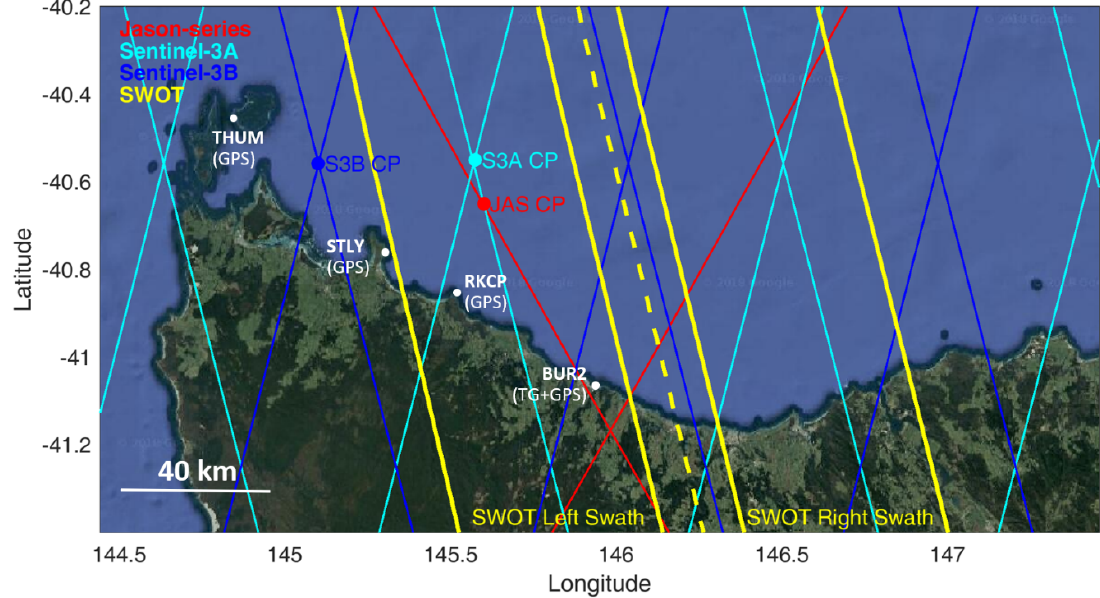
Figure 1. Detailed view of the Bass Strait altimeter validation facility. Existing comparison points (CPs) for the Jason-series, Sentinel-3A and Sentinel-3B missions are shown as coloured dots. Buoy 3, Buoy 4 and the mooring from the deployments investigated in this paper were deployed at the JAS CP (red). Mission ground tracks shown as coloured lines. The SWOT 1-day repeat fast sampling orbit is shown in yellow (swath limits shown as solid lines, centre nadir altimeter shown as a dashed line). Note the red line indicates the Jason-series ground track also to be used for the Sentinel-6 Michael Freilich mission.